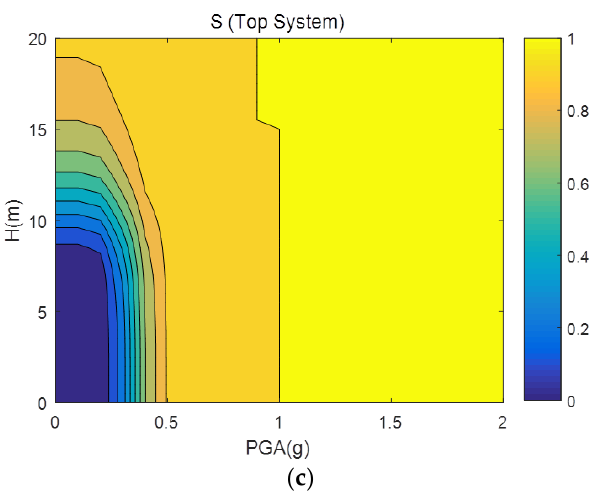
Figure 4. Comparison of the multi-hazard system fragility results regarding the example C1 ∩ C2 ((1) independent condition): ( a ) Boolean; ( b ) E-DQFM; ( c ) proposed (I-DQFM).